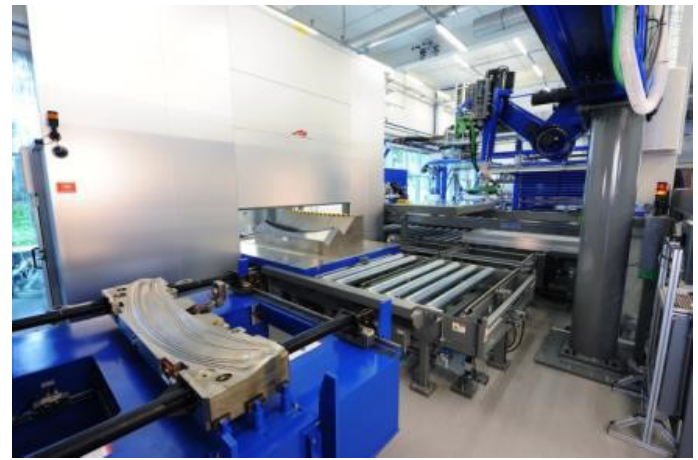
Figure 3: Preforming